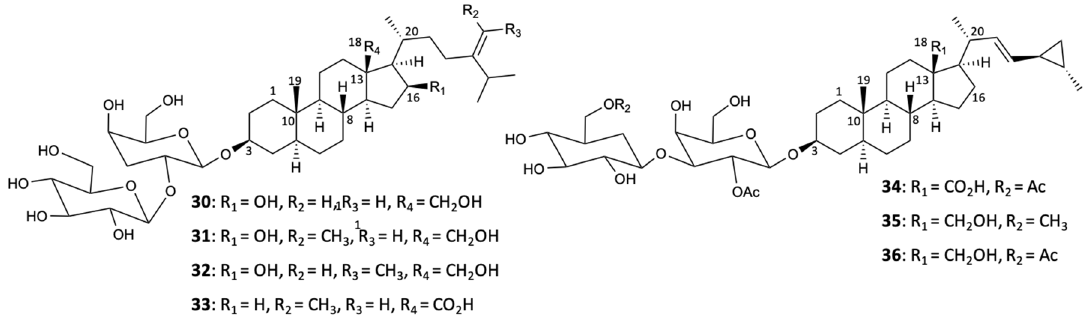
Figure 9. Structures of poecillastrosides A–G ( 30 – 36 ).